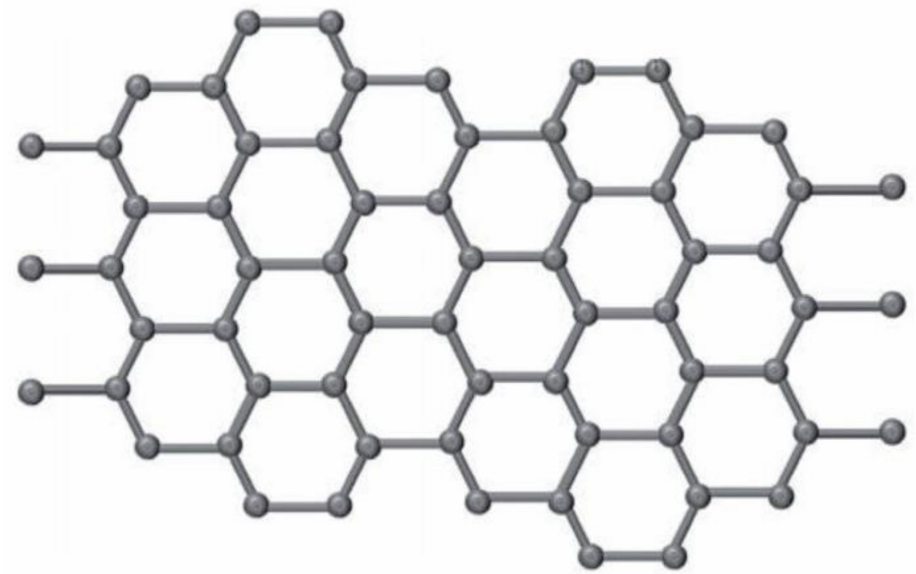
Figure 1. Structure of graphene. Reproduced from [35] under common creative 3.0. license. (Copy- right 2020, IntechOpen, London,